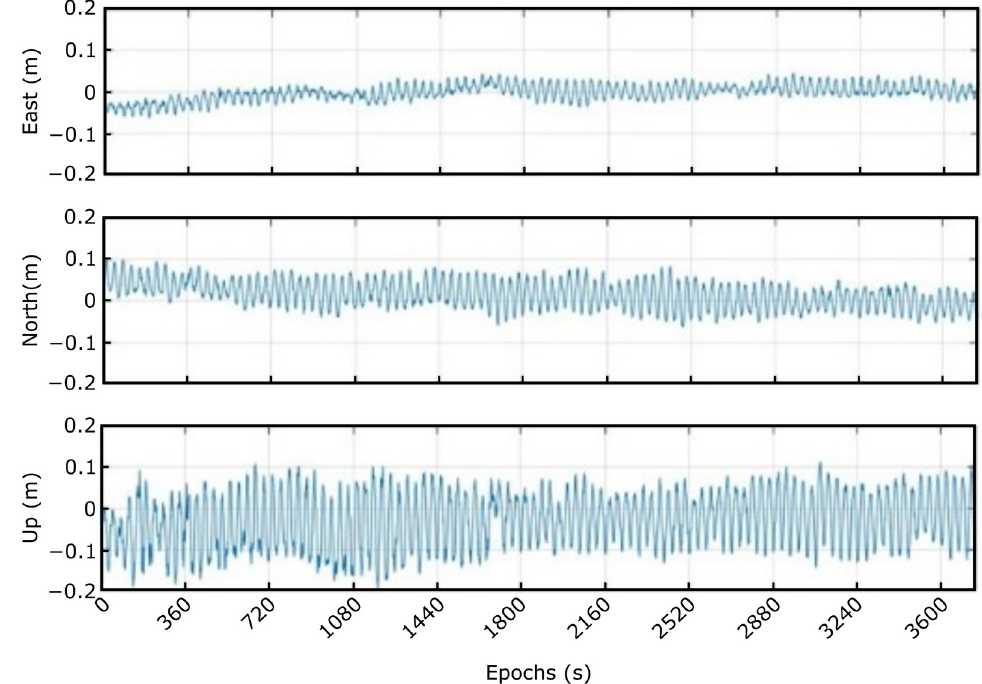
Figure 14. Solution rotating around A axis.